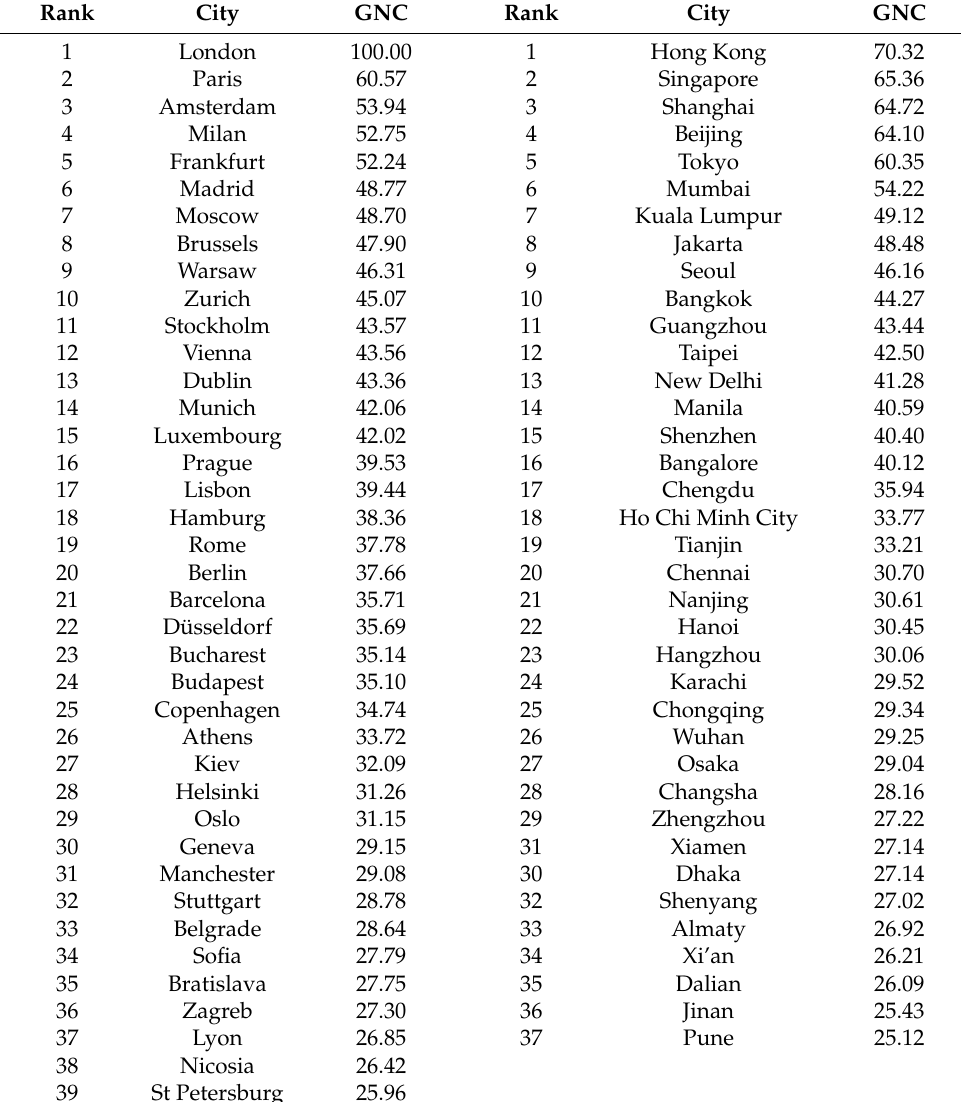
Table 2. An overview of all cities in Asia and Europe with a GNCa of at least 25%.